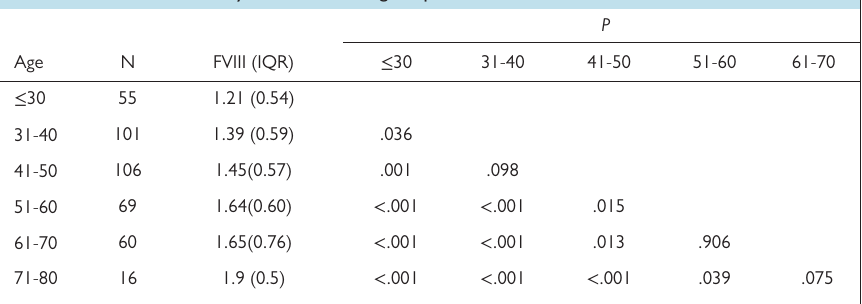
Table 4. Factor VIII Activity in Relation to Age Expressed in